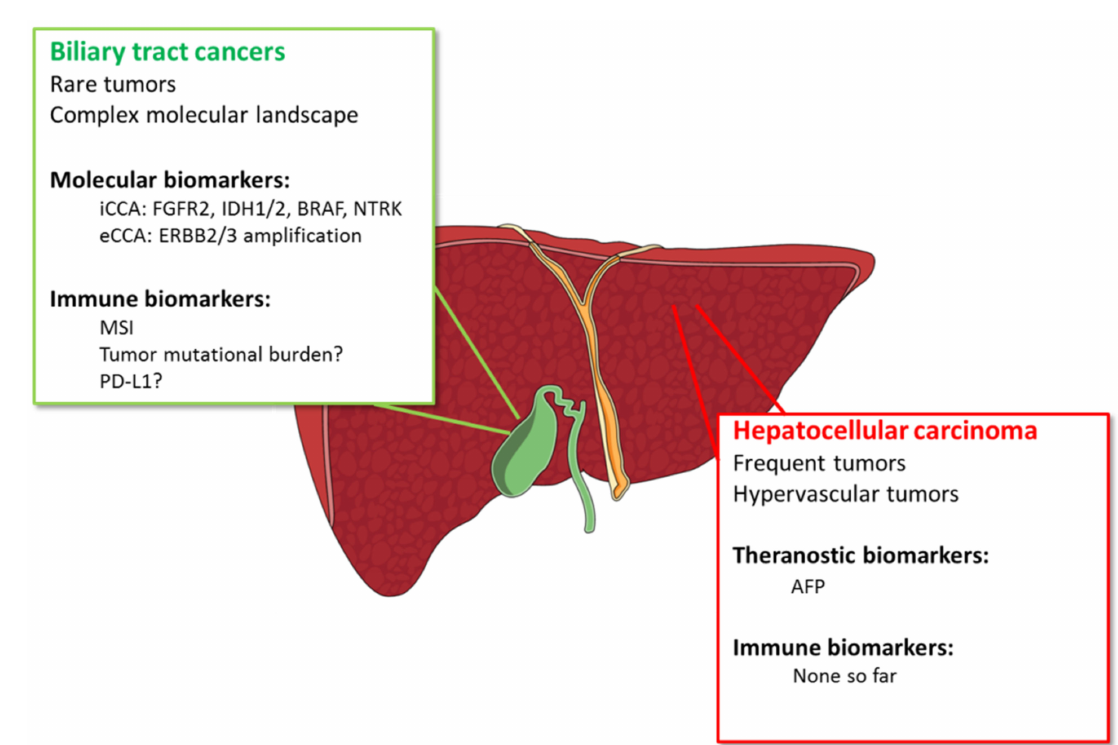
Figure 3. Theragnostic biomarkers used in biliary tract cancers and in hepatocellular carcinoma. Abbreviations: AFP: Alpha foeto-protein; ERBB: erb-b2 receptor tyrosine kinase; FGFR: fibroblast growth factor receptor; IDH: isocitrate dehydrogenase; MSI: microsatellite instability; NTRK: neurotrophic tyrosine receptor kinase; PD-L1: programmed death